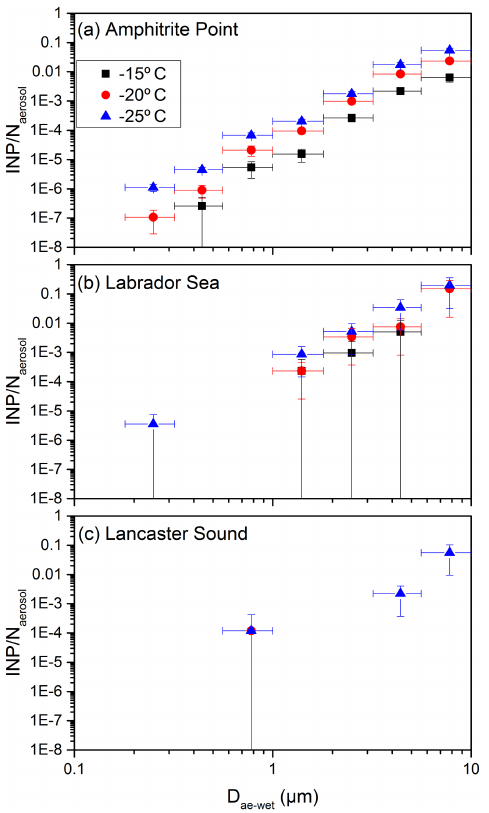
Figure 6. Surface active site density, n s , as a function of aerody- namic diameter ( D ae ) at − 15, − 20, and − 25 ◦ C, respectively. The plotted x values represent the midpoints of the size bins from the MOUDI. The x errors represent the widths of the size bins, and the y errors are the propagated uncertainties from INP concentrations as a function of size (Fig. 3) and aerosol surface-area concentrations as a function of size (Fig. S4b). In some cases, the y error bars are smaller than the size of the